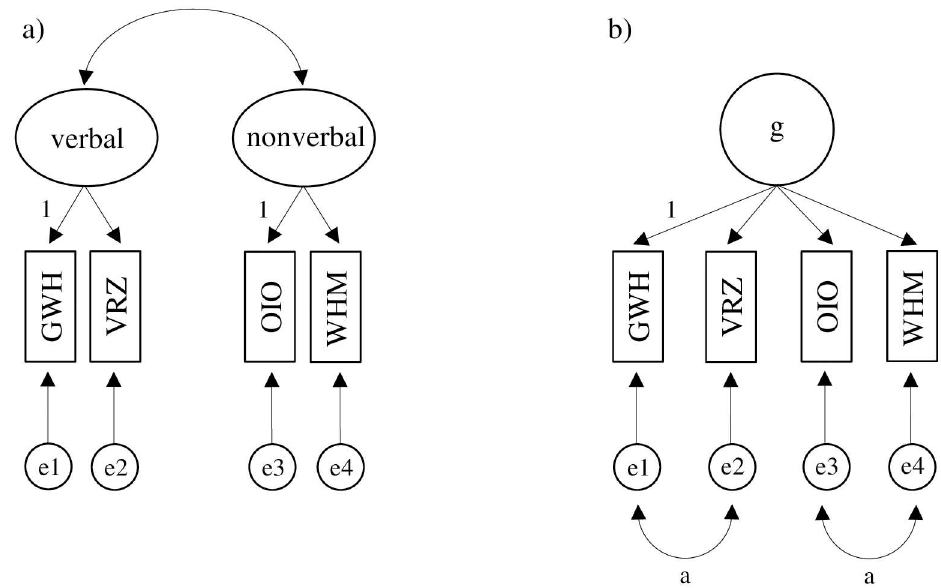
Fig 1. The Two-factor Structure (a) and Single-factor Structure (b) of the RIAS. g = general intelligence; GWH = Guess What; VRZ = Verbal Reasoning;OIO = Odd-Item Out; WHM = What’s Missing; e1-e4 = residuals; a = covariances of the residuals were set to be equal across